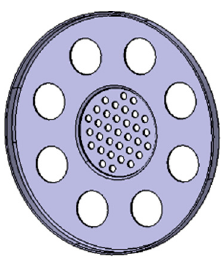
Figure 3. Initial Figure 3. Initial design.